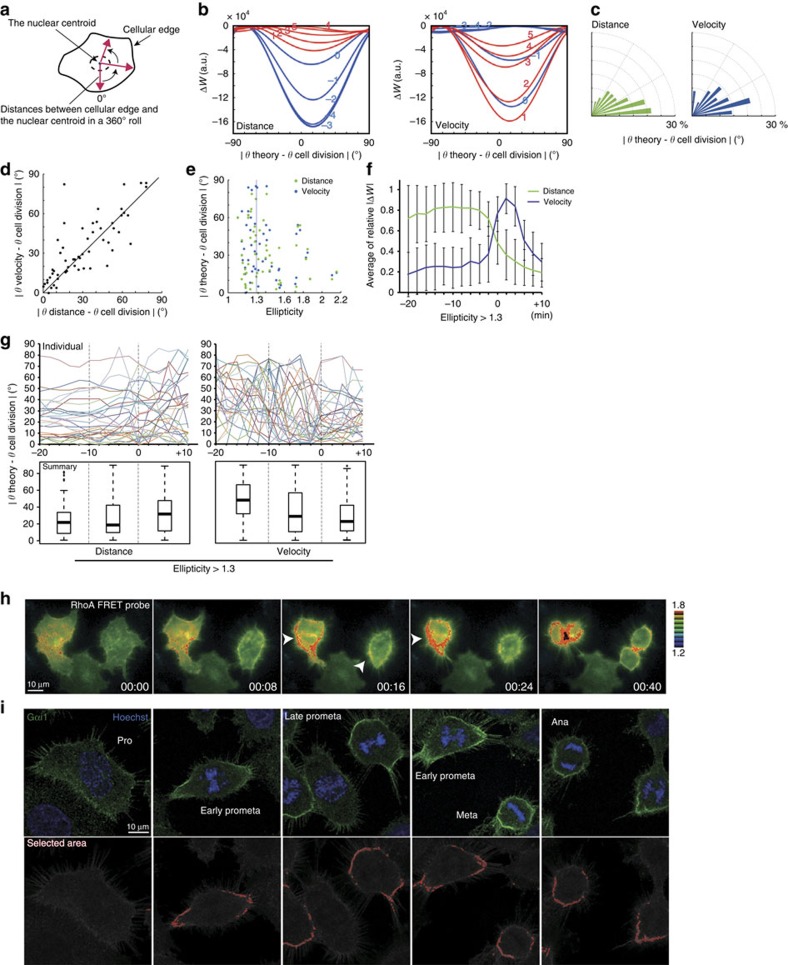
Velocity of cellular edge retraction during mitotic cell rounding is a cue that dictates the spindle orientation.(a) Scheme for measuring cellular geometry. (b) The theoretical potential energy landscape (ΔWdistance and ΔWvelocity) of a representative example is shown. Blue and red lines represent ΔW before and after onset of mitotic cell rounding, respectively. The angle with the lowest ΔW is defined as the theoretical angle in each sample. Each number represents time points. (c) Angular distribution (n=55) of accuracy of the predicted spindle orientation. (d) Scatter plot comparing the accuracy of the predicted spindle orientation by distance- versus velocity-based methods in each sample. (e) Dot plot representing the prediction accuracy with respective ellipticity (ratio of the length of the longest/shortest cell axis). (f) Fold change of the average of ΔW at every 10 min (five frames) in cells with more (left) or less (right) than 1.3 ellipticity. Time 0 represents the onset of cell rounding (see Methods). (g) Angular difference between the theoretical and actual spindle angles at each time point in every sample (upper). Theoretical angles were calculated by distance- (left) or velocity-based (right) methods in cells with more than 1.3 ellipticity. Box plots representing the angles for every 10 min (five frames) are shown at the bottom. (h) Time-lapse serial ratio images of the RhoA FRET probe expressed in HeLa cells. (i) Images of Gαi1 (green) and Hoechst (blue) in HeLa cells from prophase to anaphase. A region with higher Gαi1 intensity than a certain threshold is represented as an enclosed red area at the bottom.